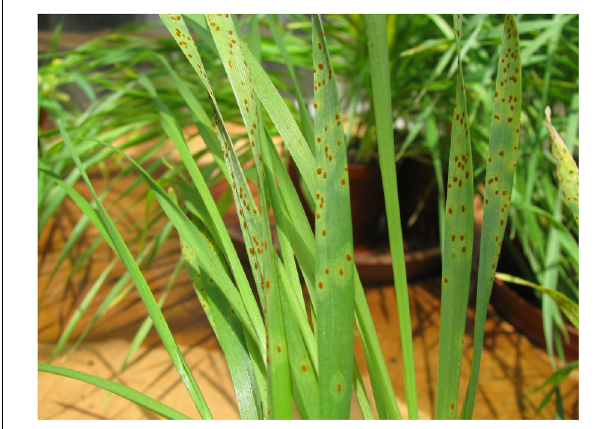
FIGURE 8 | Puccinia triticina infection obtained with an inoculator produced with AM.